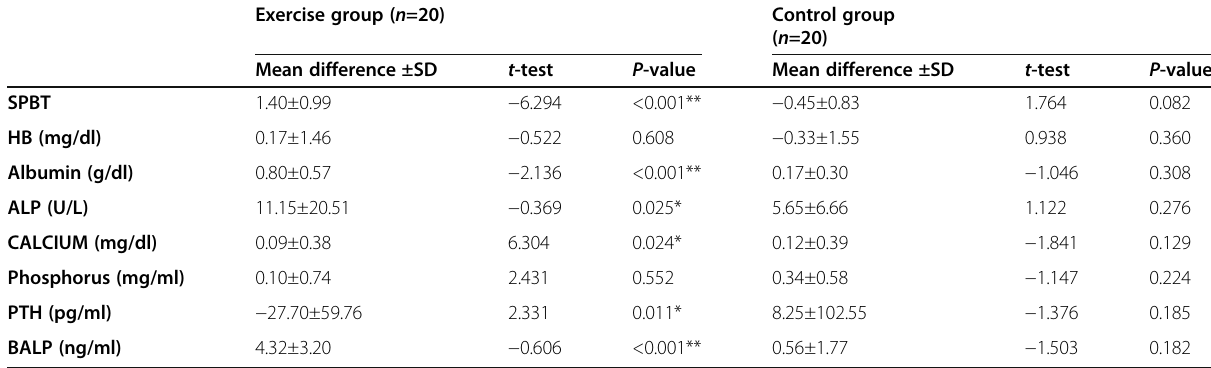
Table 4 Change in physical performance and laboratory data in the exercise group and control group after 3 months follow-up